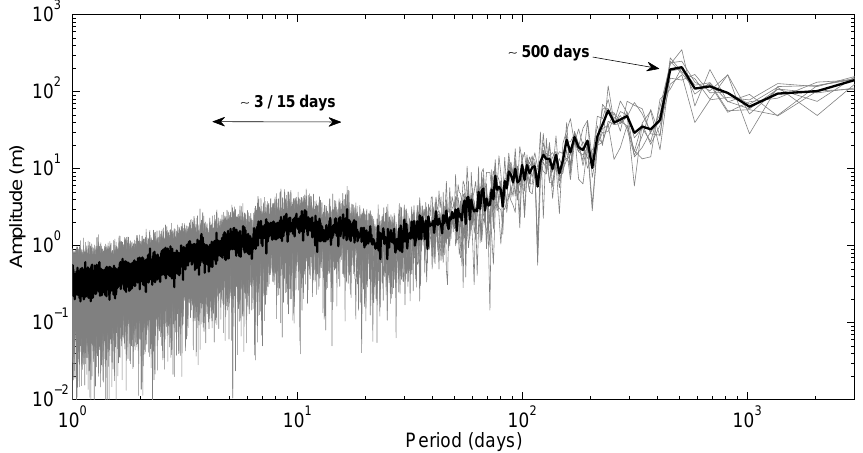
Figure 9. Frequential response of variation in the calving front in the eight simulations using the set of parameters ( σ th = 0.11MPa, B = 1.30MPa − 1 , D c = 0.50), computed over 10 years. Gray lines represent the frequency spectrum for each of the eight simulations, and the solid black line shows the corresponding